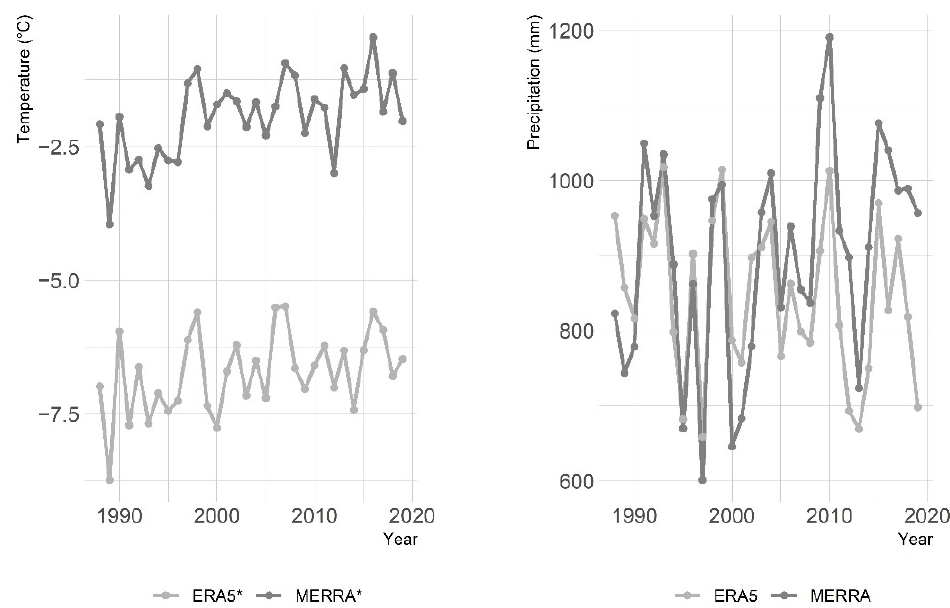
Figure 7. Annual mean temperature time series ( left ) and annual mean precipitation time series ( right ) of ERA5 and MERRA from 1988 to 2020 (* indicates significant trends, p < 0.01; data sources: [108,109]).